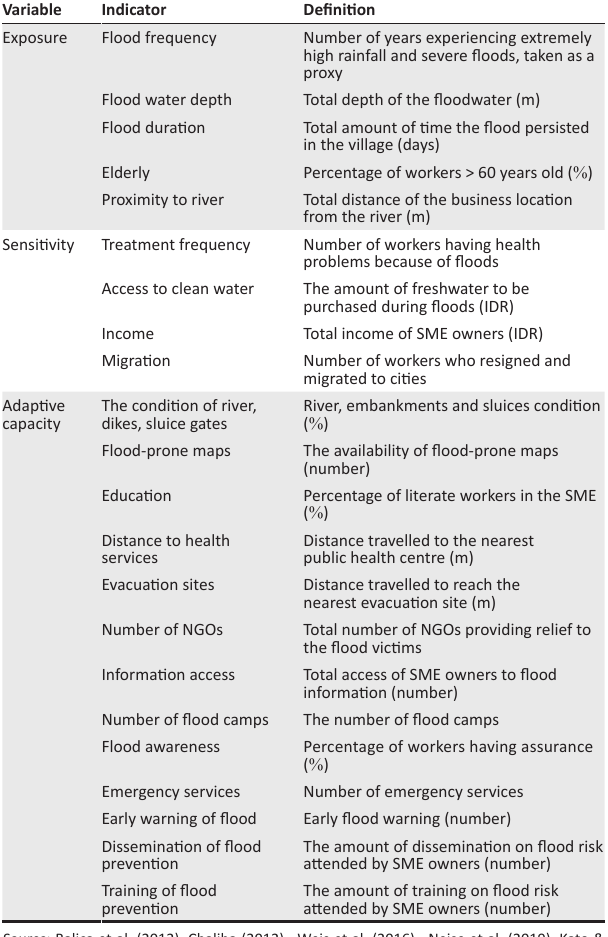
Table 1: Vulnerability variables and